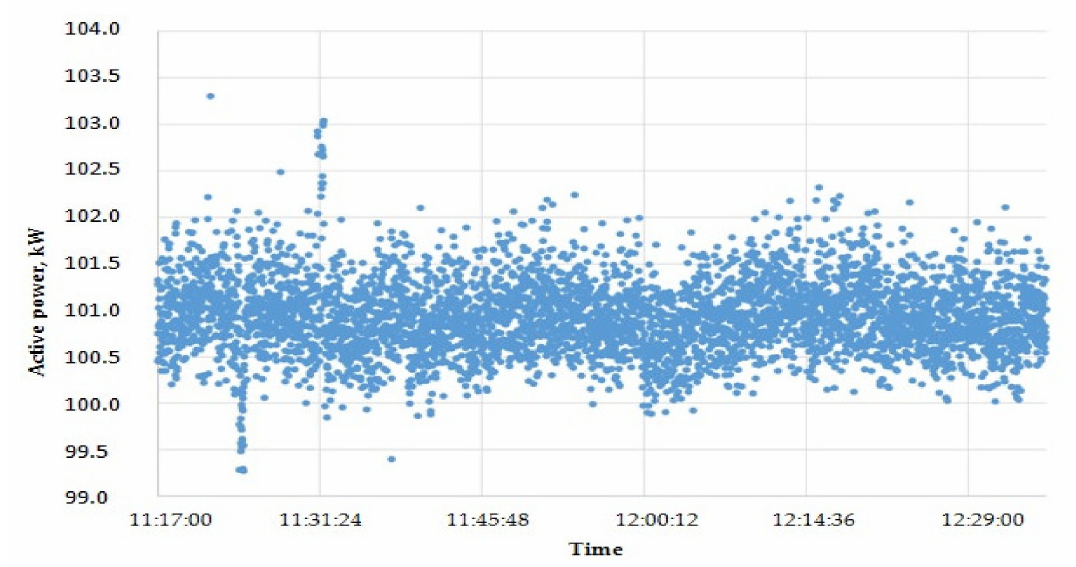
Figure 6. Active power curve for all S428.CS dryer equipment.